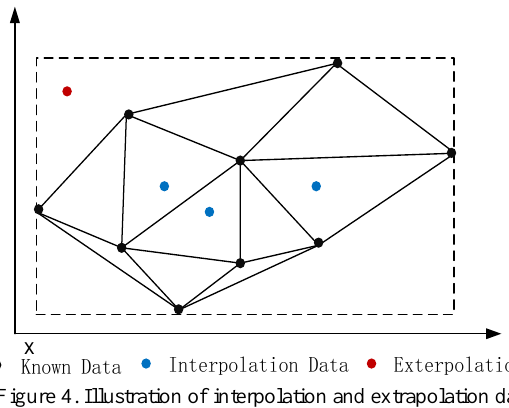
Figure 4. Illustration of interpolation and extrapolation data.